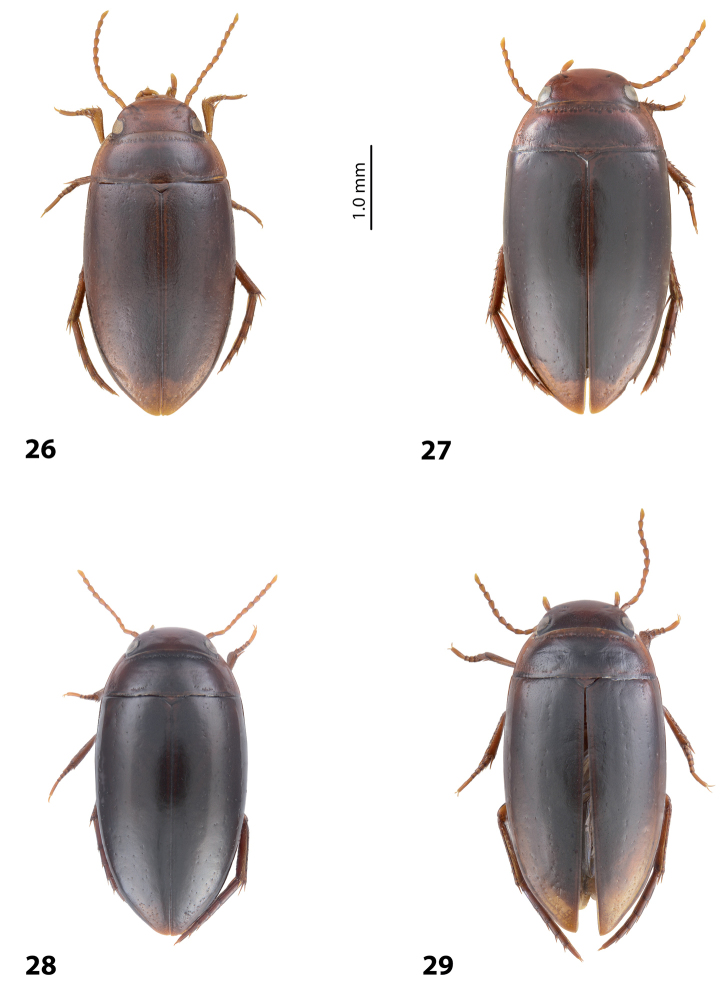
Habitus and colouration 26Exocelina
aseki sp. nov. 27E.
jaseminae (Balke, 1998) 28E.
kailaki sp. nov. 29E.
pseudojaseminae sp. nov.